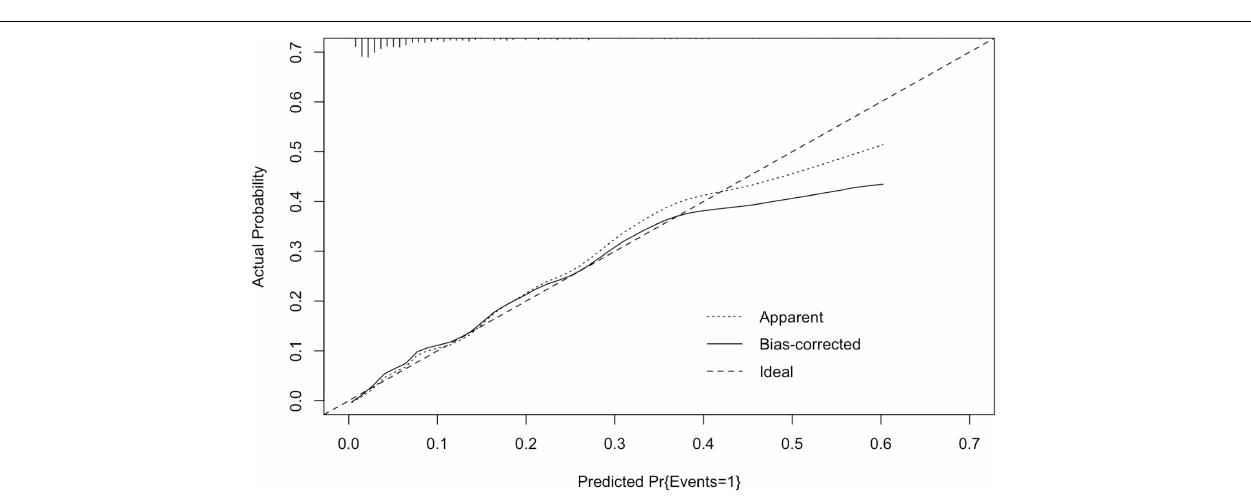
FIGURE 4 | Calibration curve of nomogram model in the development cohort. The standard curve was a straight line passing through the origin of the coordinate axis. If the predicted calibration curve is closer to the standard curve, the better the prediction ability of the nomogram. “Bias-corrected” was the correction curve, while “Ideal” was the standard curve. The graphical predicted and measured values are basically consistent, indicating that the nomogram model of this study has a good